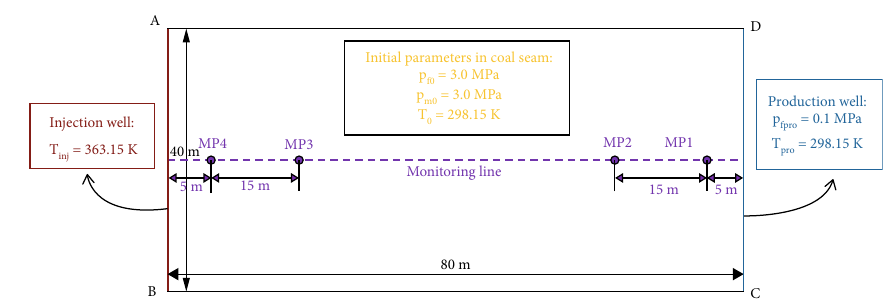
Figure 8: Computational model for simulating.